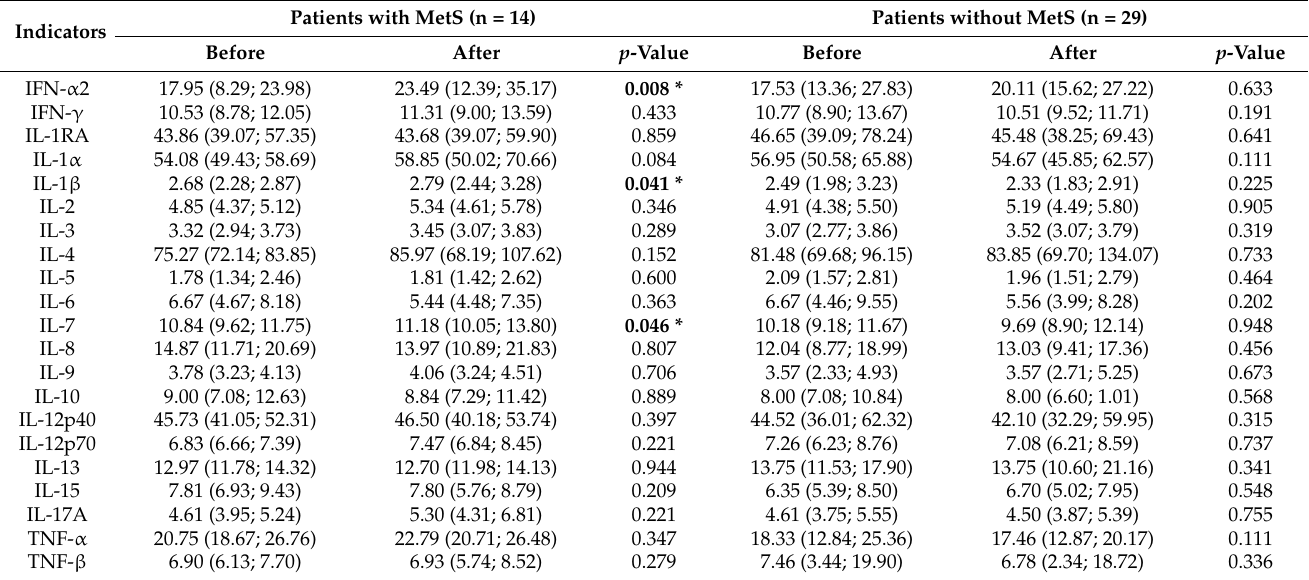
levels. We did not find any changes in the cytokine levels in the individuals without MetS who received risperidone for 6 weeks (Table 3). Table 3. Serum concentrations of the cytokines (pg/mL) in patients with and without MetS during 6 weeks of risperidone therapy, Me (Q1; Q3).